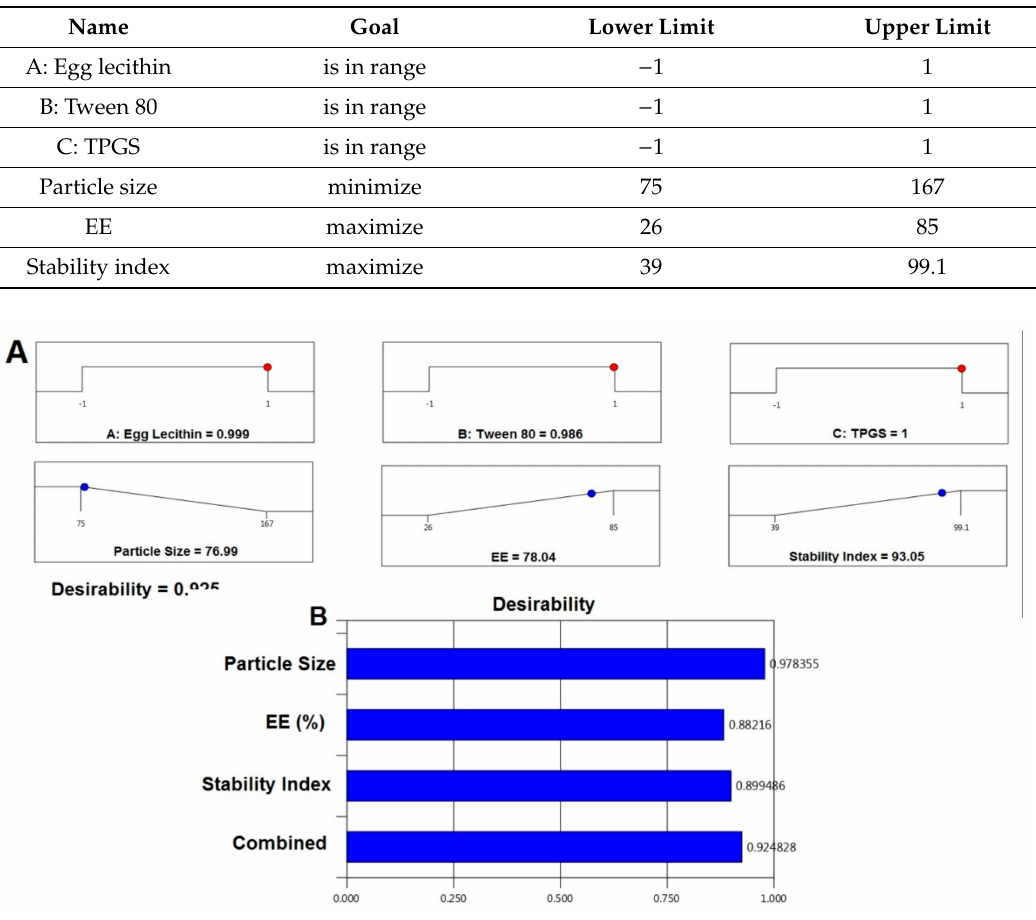
Figure 4. Desirability ramp and bar chart for optimization. ( A ). Desirability ramp shows the levels for independent variables and predicted values for the responses of the optimum formula; ( B ). Bar Chart shows the desirability values for the combined